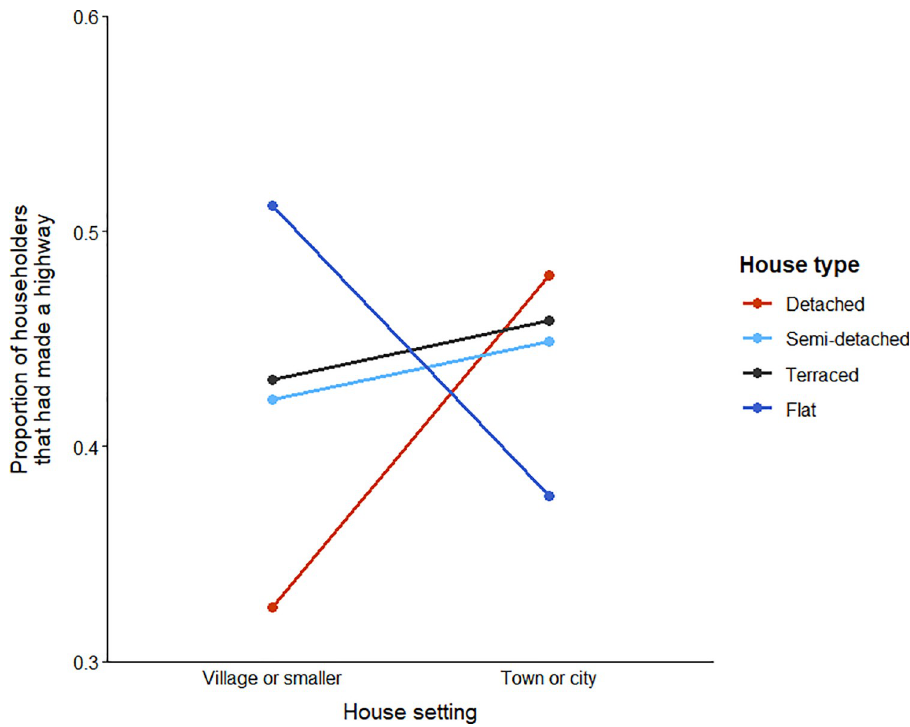
Fig 4. Probability that householders (N = 5986) had created a hedgehog highway in relation to house type and house location.